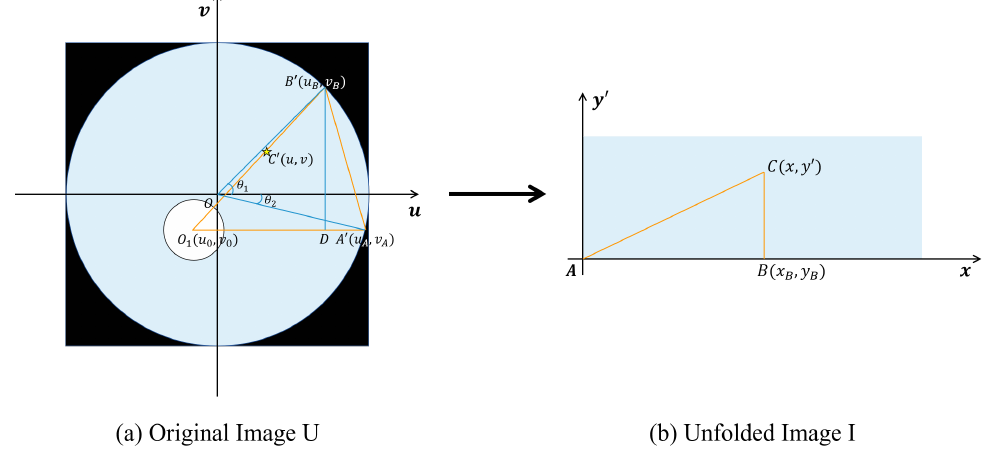
Figure 2. Original image and unfolded